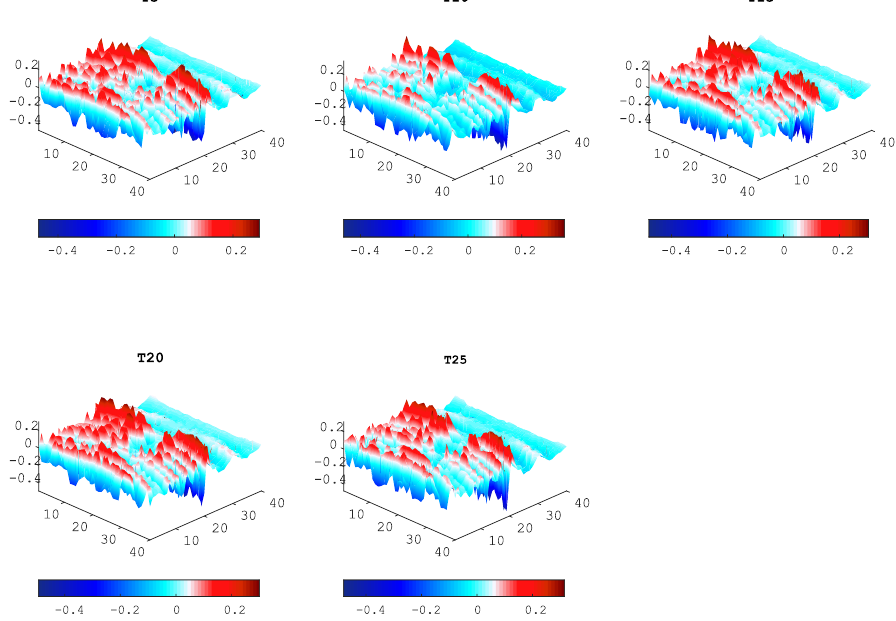
Figure 10. UWPI snapshots from five looseness (T) conditions at t = 37 µ